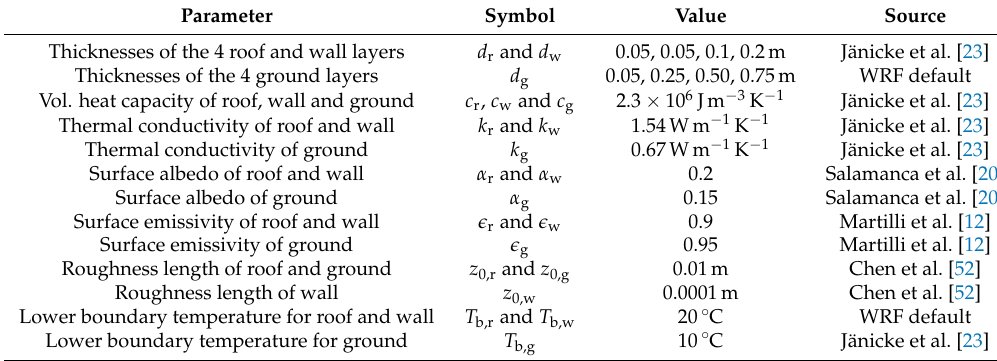
Table 5. Building properties used in the urbanized WRF simulations (SLUCM or